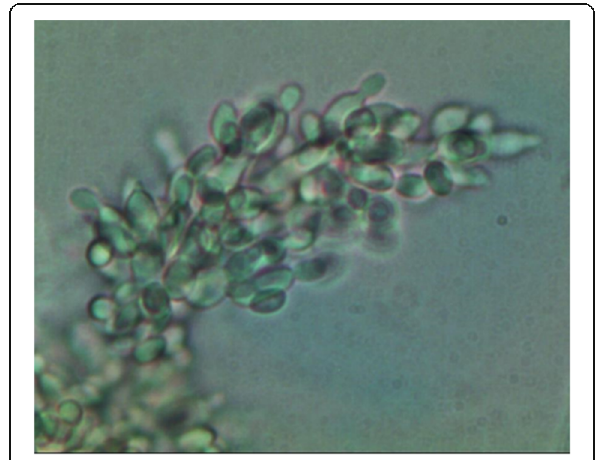
Fig. 5 Light microscopic observations of conidia and conidiophores of Metarhizium rileyi grown on SMYA medium (× 400)